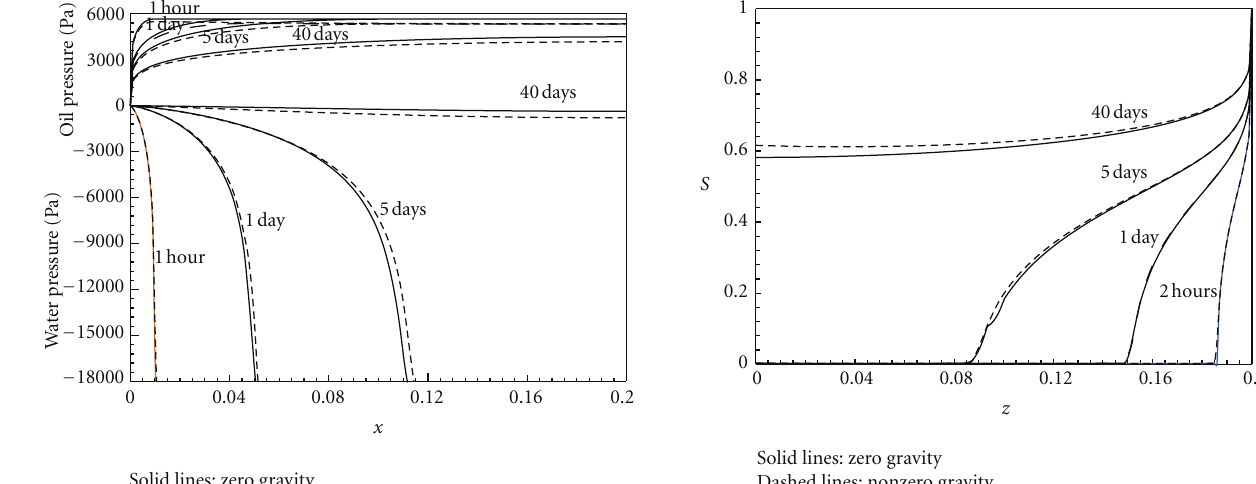
Solid lines: zero gravity Dashed lines: nonzero gravity Figure 7: Comparison between considering and neglecting gravity e ff ect on water saturation against z -axis of Case B, at x = 0 . 15 m.